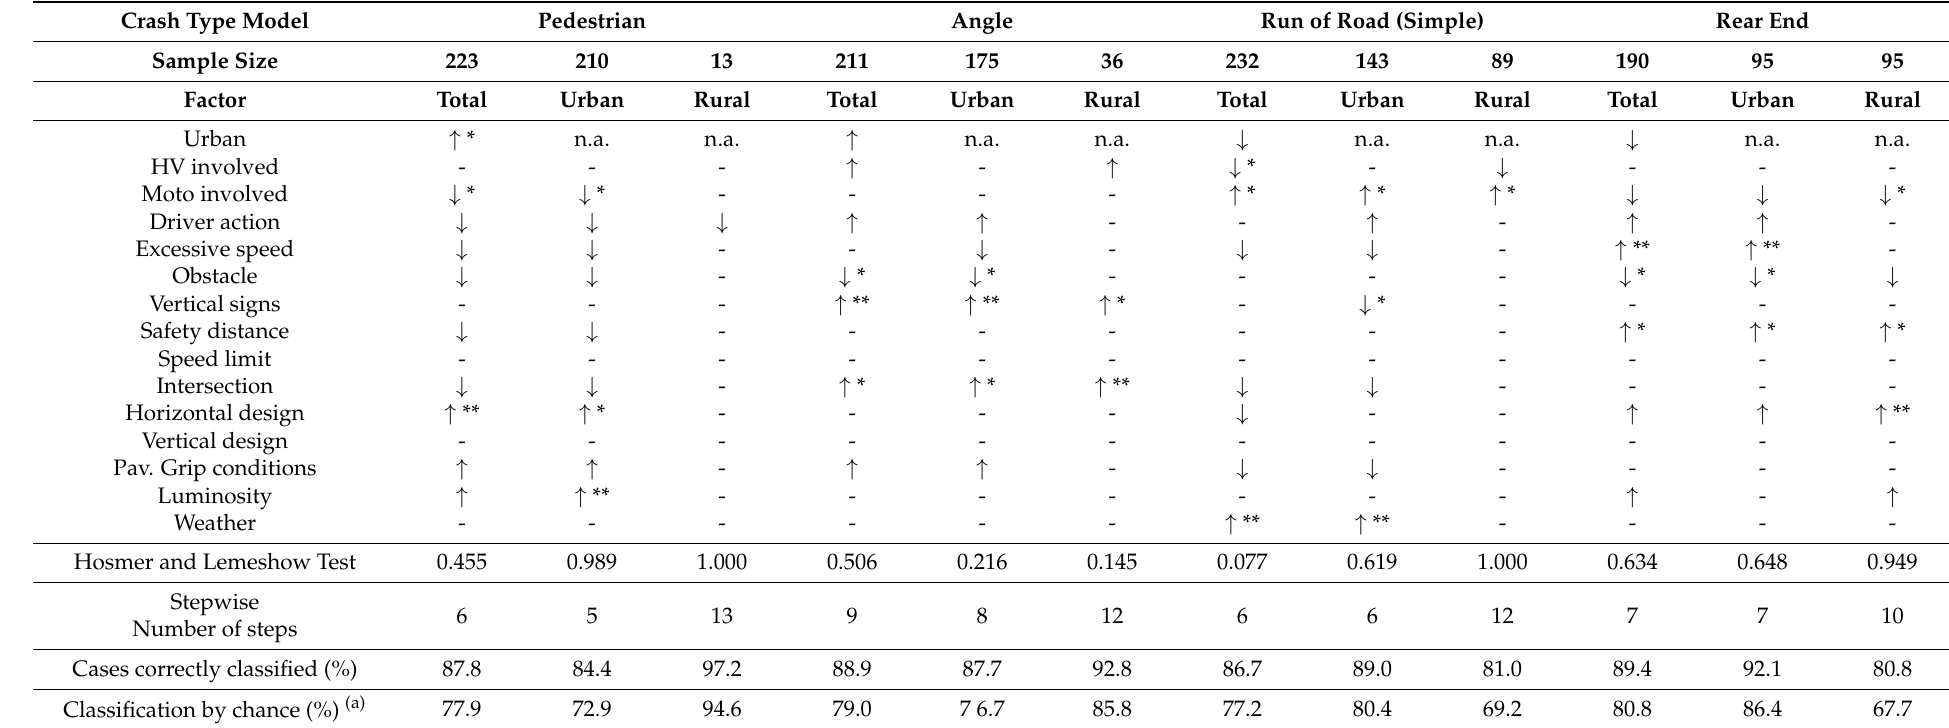
Table 6. Summary of model qualitative findings for crash